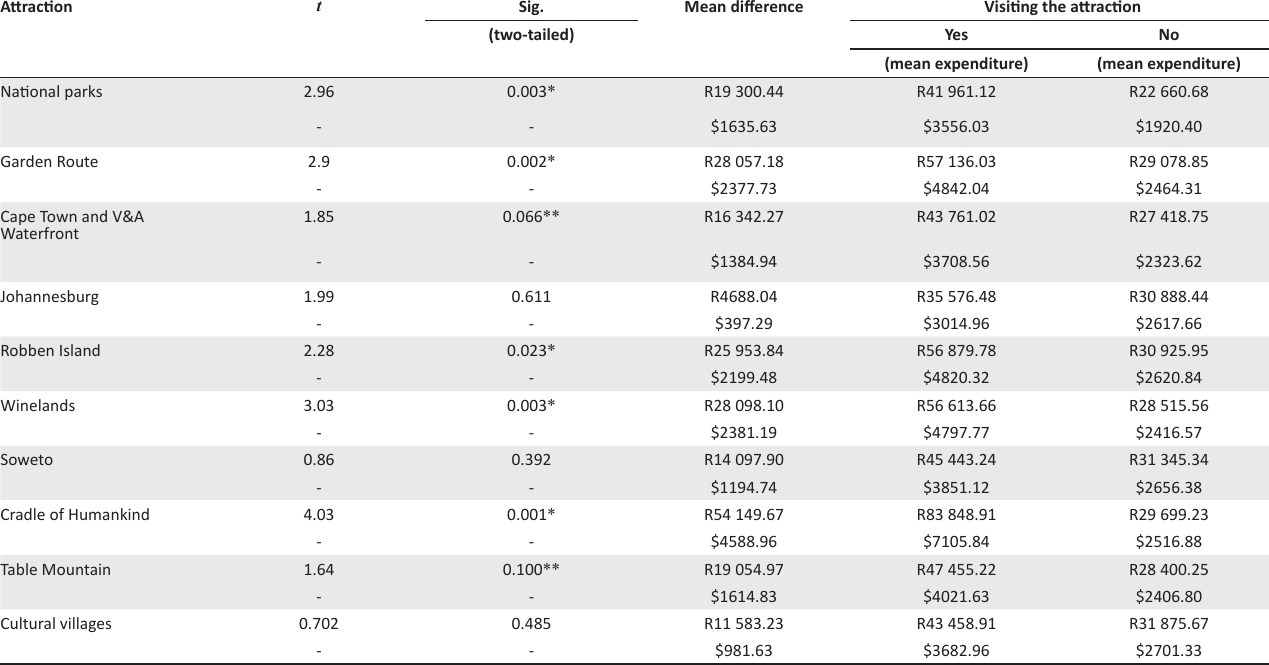
TABLE 5: Mean differences in expenditure-based on activities and destinations. Attraction